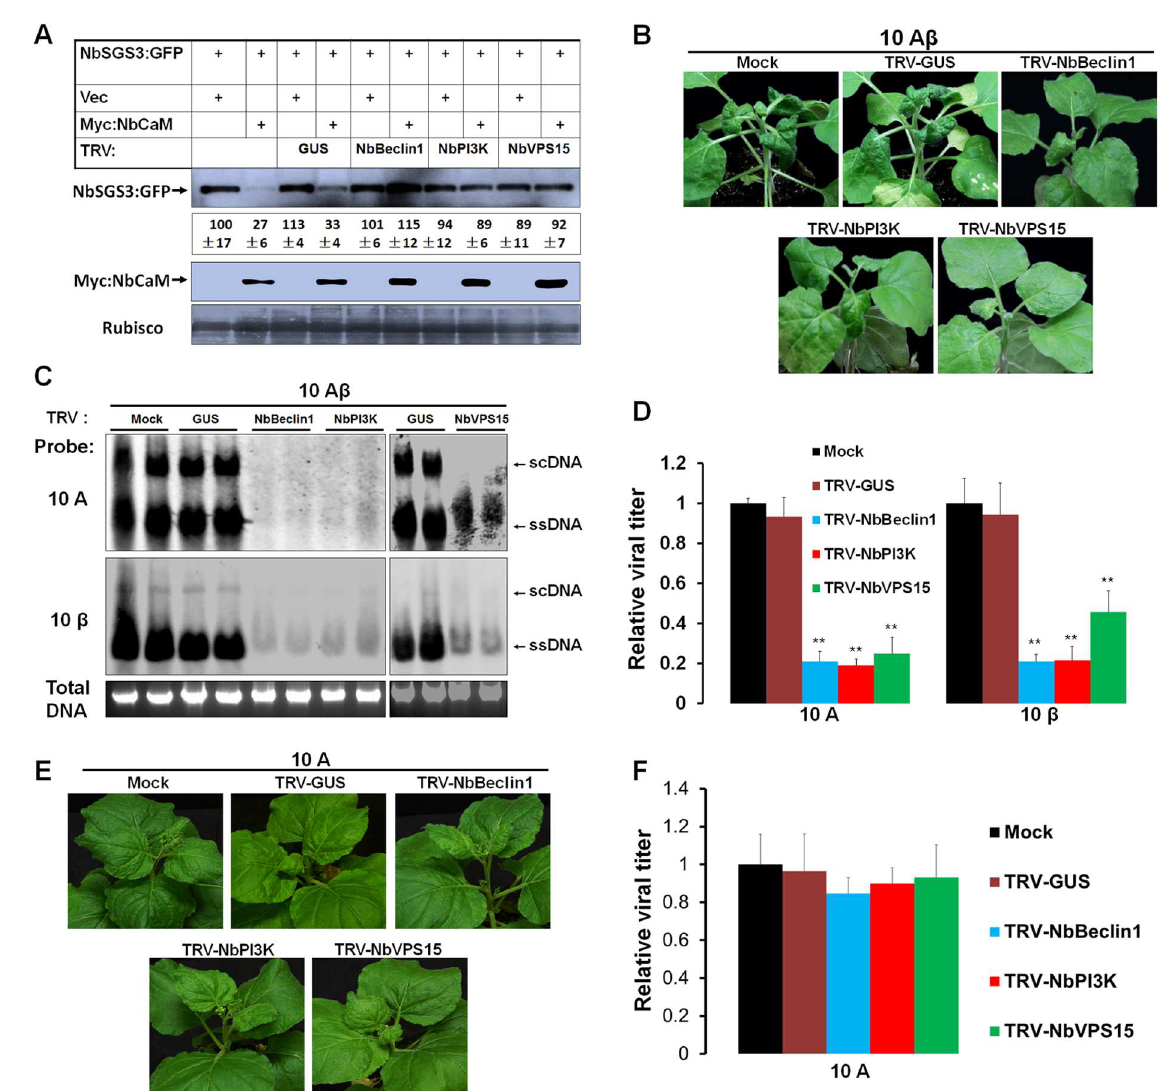
Fig 6. Silencing of NbBeclin1 , NbPI3K or NbVPS15 leads to inhibition of NbSGS3 degradation mediated by NbCaM and reduces the infection of geminivirus associated with betasatellite. (A) Silencingof NbBeclin1 , NbPI3K or NbVPS15 inhibits NbCaM-mediated NbSGS3 degradation. N . benthamiana plants were first inoculatedwith TRV vectors carrying partial fragments of GUS , NbBeclin1 , NbPI3K or NbVPS15 at the 4–5 leaf stage. Plants were then infiltrated at 21 dpi with NbSGS3:GFP plus Vec or NbSGS3:GFP plus Myc:NbCaM as indicated(top chart). Total protein was extracted from infiltrated leaves at 2 dpi, and GFP and Myc antibodiesused in Western blot analyses. Coomassie brilliantblue staining of Rubiscolarge subunit was used as a loadingcontrol. A representative Western blot from at least three independentexperiments is shown. NbSGS3:GFP protein bandswere quantified using Image J software, and the protein level in leaves co-expressing NbSGS3:GFP and empty vector (Vec) in no-TRV infected plants was set at 100. Values represent the averagelevel of protein ± standard deviation(SD). (B) Symptoms of mock, TRV-GUS and NbBeclin1 , NbPI3K or NbVPS15 -silencedplants infectedby 10A β at 14 dpi. Systemic leavesof NbBeclin1 , NbPI3K or NbVPS15 -silencedplants at 7 dpi were then infectedwith TYLCCNV+TYLCCNB (10A β ).( C )Southernblots of 10A β DNA accumulation using 30 μ gof total DNA isolatedfrom systemic leavesof six plants shownin ( B )at 14 dpi. The agarosegel was stainedwith ethidiumbromideas a loading control. Viral single-stranded DNA (ssDNA) andsupercoiledDNA (scDNA) are indicated. ( D )Relative10A and 10 β DNA levelsin plants shownin (C) normalizedto 25S rRNA that servedas an internalplant genomicDNA control. The uppernewlyinfected leaveswere harvestedand 100ng total DNA used for relativequantitative PCR. The levelof 10A or 10 β DNA in mock-treated plants is arbitrarily set as 1. Valuesrepresentthe mean ± standarddeviation (SD) (n = 9). Doubleasterisksindicatea highlysignificant difference (p < 0.01) betweenmock-treatedand ATG s-silencedplants(student’s t test). (E) Symptoms of mock, TRV-GUS and NbBeclin1 , NbPI3K or NbVPS15 -silencedplants infectedby 10A at 14 dpi. ( F )Relative10A DNA levels in plantsshownin (E) normalized to 25S rRNA that served as an internalplantgenomicDNA control. The uppernewlyinfected leaveswereharvestedand 100 ng total DNA were used for relativequantitative PCR. The level of 10A DNA in mock-treated plantsis arbitrarily set as 1. Valuesrepresentthe mean ± standard deviation(SD) (n =